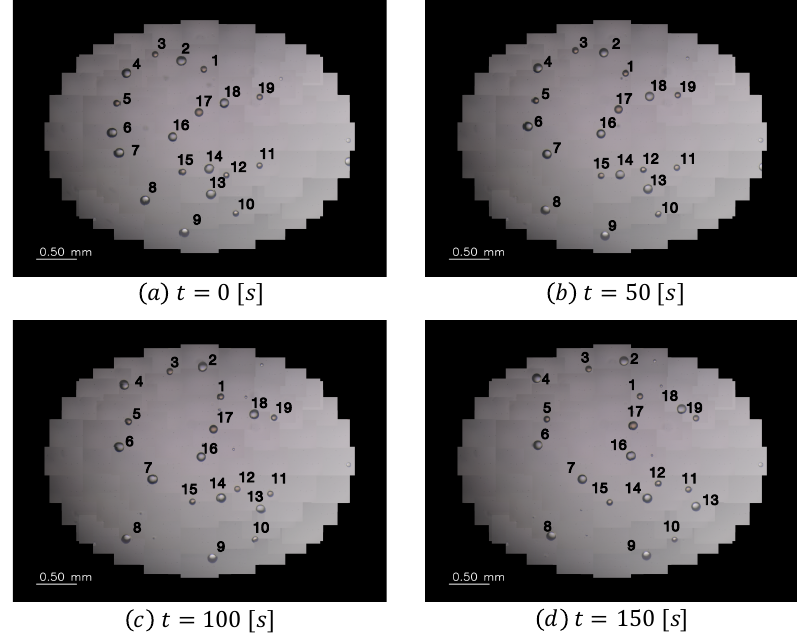
Figure 9. Large field-of-view images.